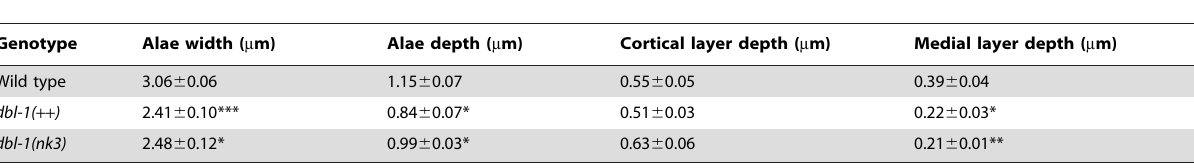
Table 2. DBL-1 levels affect the dimension of cuticular